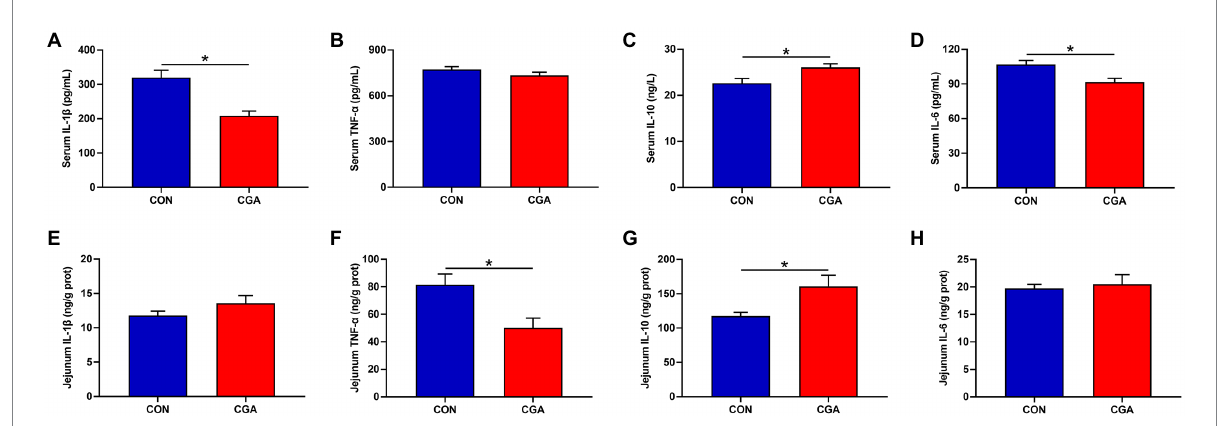
FIGURE 3 Effects of CGA on the levels of critical inflammation-related molecules in the serum (A–D) and jejunum (E–H) of weaned rabbits. IL-1 β , interleukin 1 beta; TNF- α , tumor necrosis factor-alpha; IL-10, interleukin 10; IL-6, interleukin 6; CON, rabbits fed a basal diet; CGA, rabbits fed the basal diet supplemented with 800 mg/kg chlorogenic acid. Results are presented as mean and SEM ( n = 8). Significant difference was recorded by 0.01 < p < 0.05*.